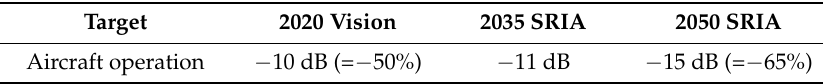
Table 2. Advisory Council for Aviation Research in Europe (ACARE) targets of noise reduction. Target